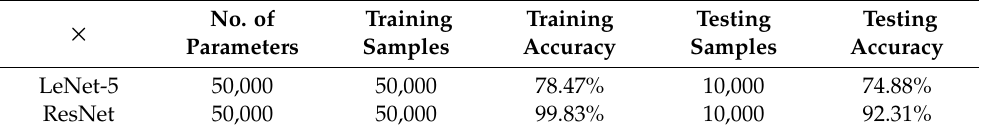
Table 2. Summary of trained CNN